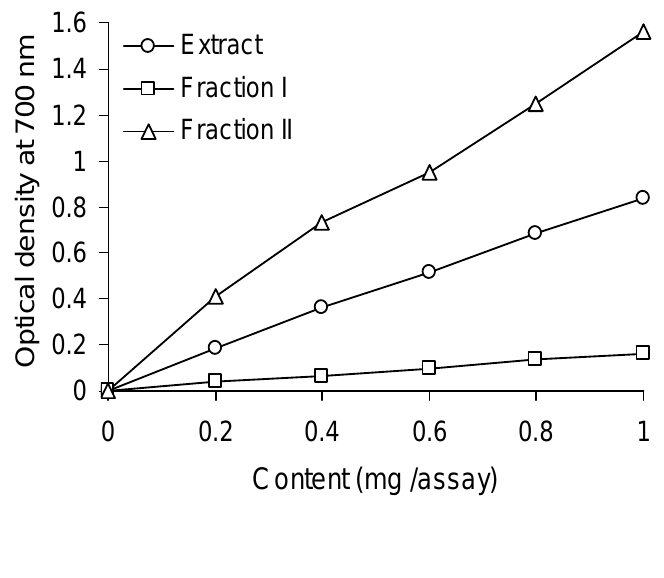
Figure 3. Reducing power of a red lentil acetonic extract end its fractions, as measured by changes in optical density at 700